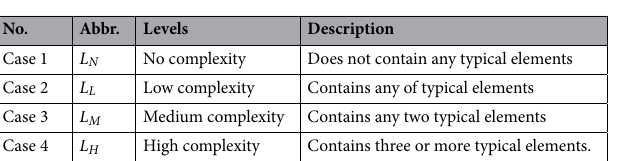
Figure 1. Examples of open water and 5 typical complex elements.